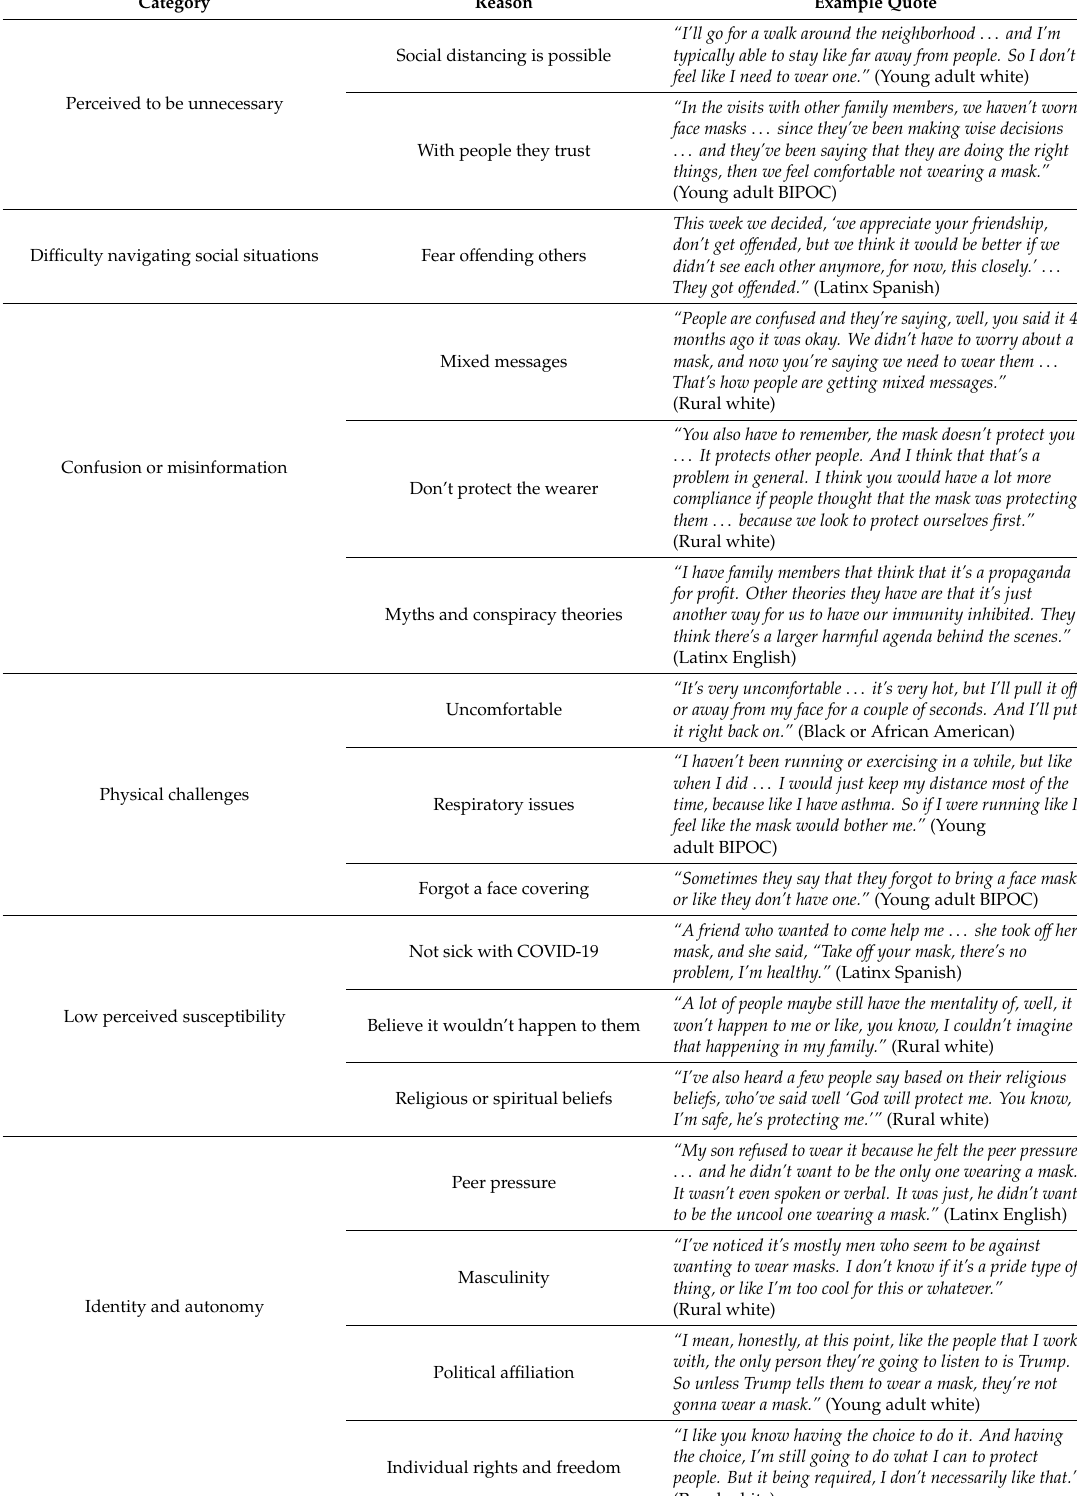
Table 3. Reasons for not using face coverings among North Carolina